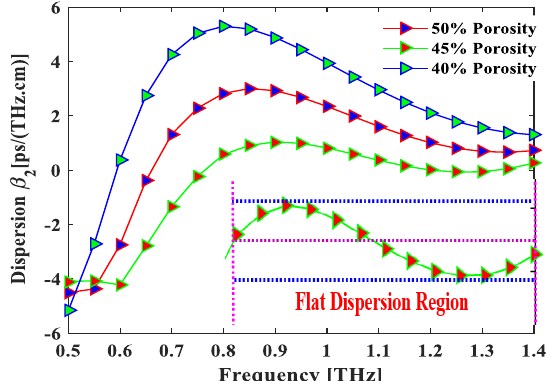
Figure 8. The dispersion of different porosities as a function of